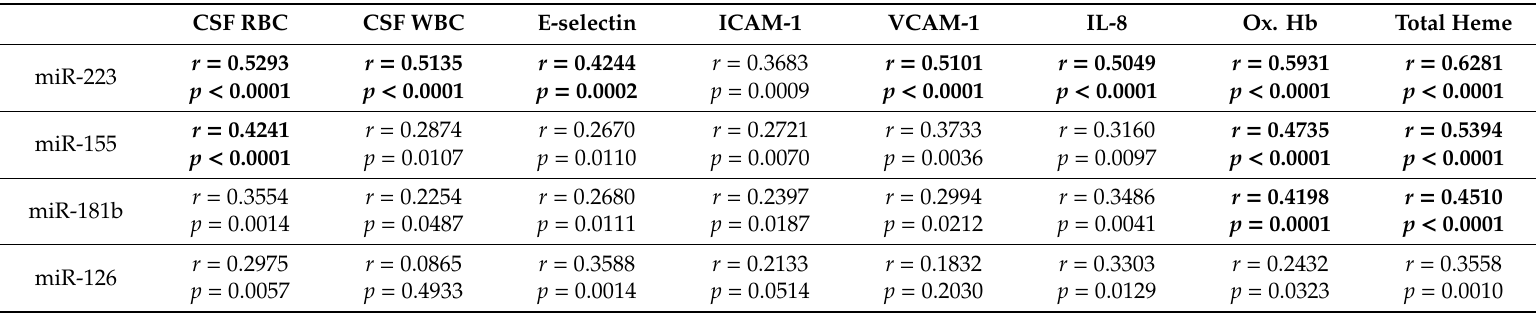
Table 2. Correlation analysis of CSF miRNA expression with pro-inflammatory protein biomarkers and oxidized Hb forms in IVH. Results are expressed as r (correlation coe ffi cient) and p values according to the comparison between respective corresponding parameters. Strong statistically significant positive correlations are highlighted in bold. The relationship between miRNA levels and other parameters was characterized using Spearman’s